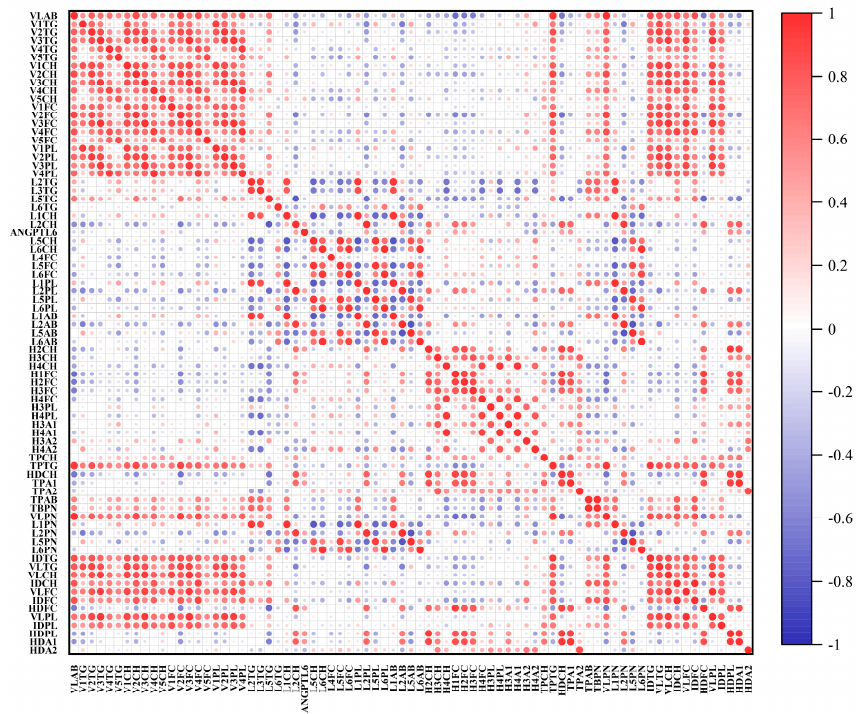
Figure 13. The correlation of serum ANGPTL6 and selected lipoprotein subfractions was analyzed using Spearman’s rank correlation analysis. Spearman’s rank correlation coefficient ranges from − 1 to 1. The lipoprotein subfractions are annotated in Table S12.